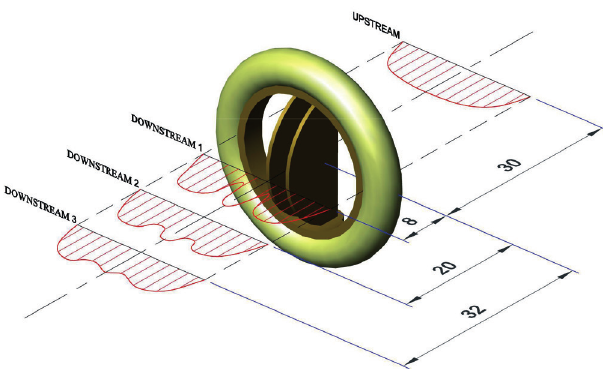
Fig. 4 - Measurement sections referenced at the prosthesis positioning Highlighted: in the flow direction, upstream at 30 mm, downstream 1 at 8 mm, downstream 2 at 20 mm and downstream 3 at 32 mm from the valve